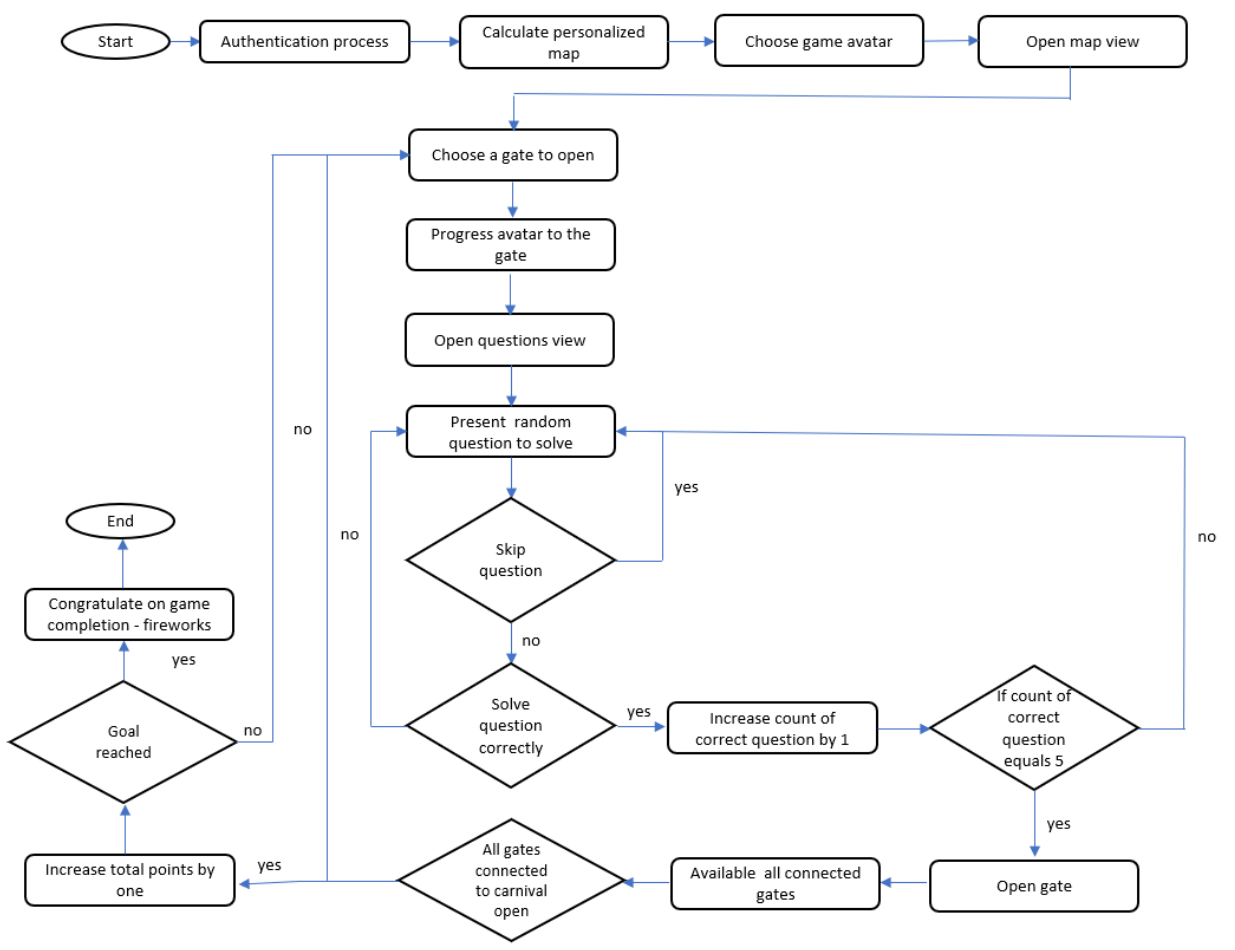
Figure 3. Schematic representation on the game